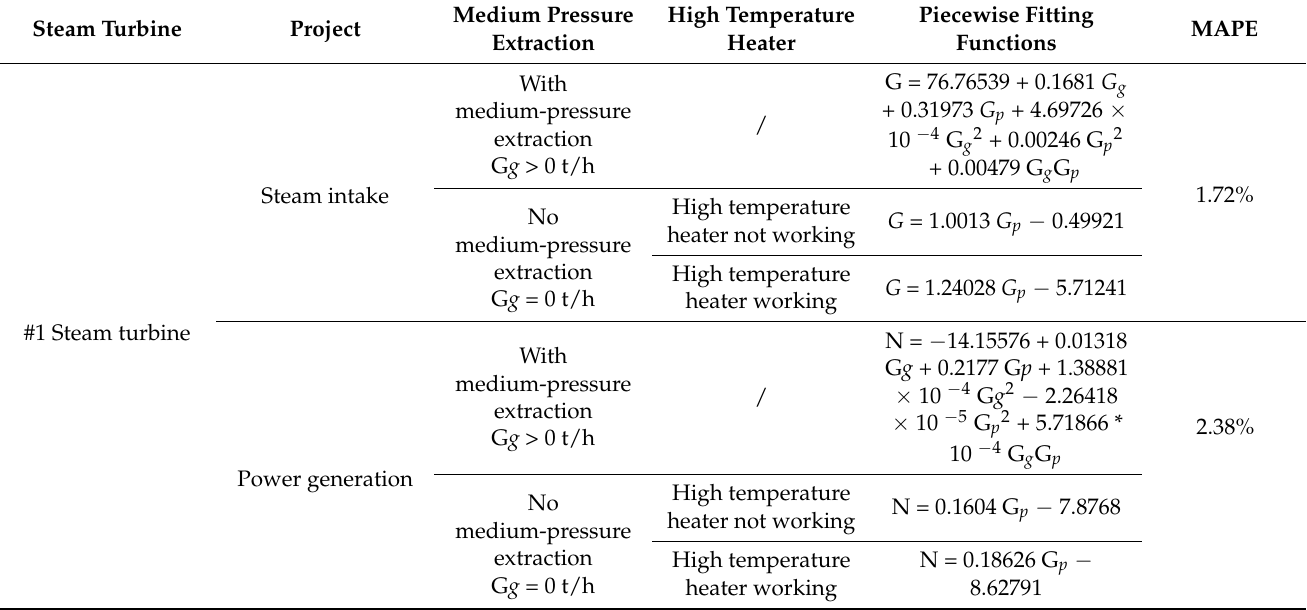
Table A1. Piecewise fitting load characteristic equation of turbine